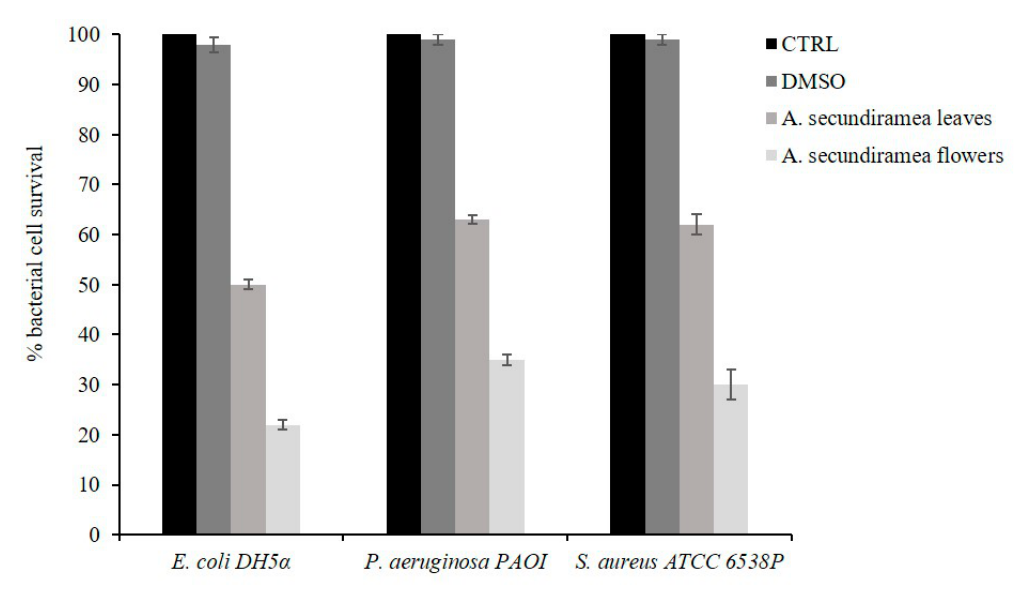
Figure 5. Antibacterial activity of A. secundiramea essential oils from flowers and leaves, evaluated by colony count assay, against E. coli DH5 α , P. aeruginosa PAOI , and S. aureus ATCC 6538P at a fixed concentration of 500 µ g / mL. Untreated cells represented control because negative controls are bacterial cells with dimethyl sulfoxide (DMSO 2%). Each bar is the average of three di ff erent experiments. p value is < 0.05.